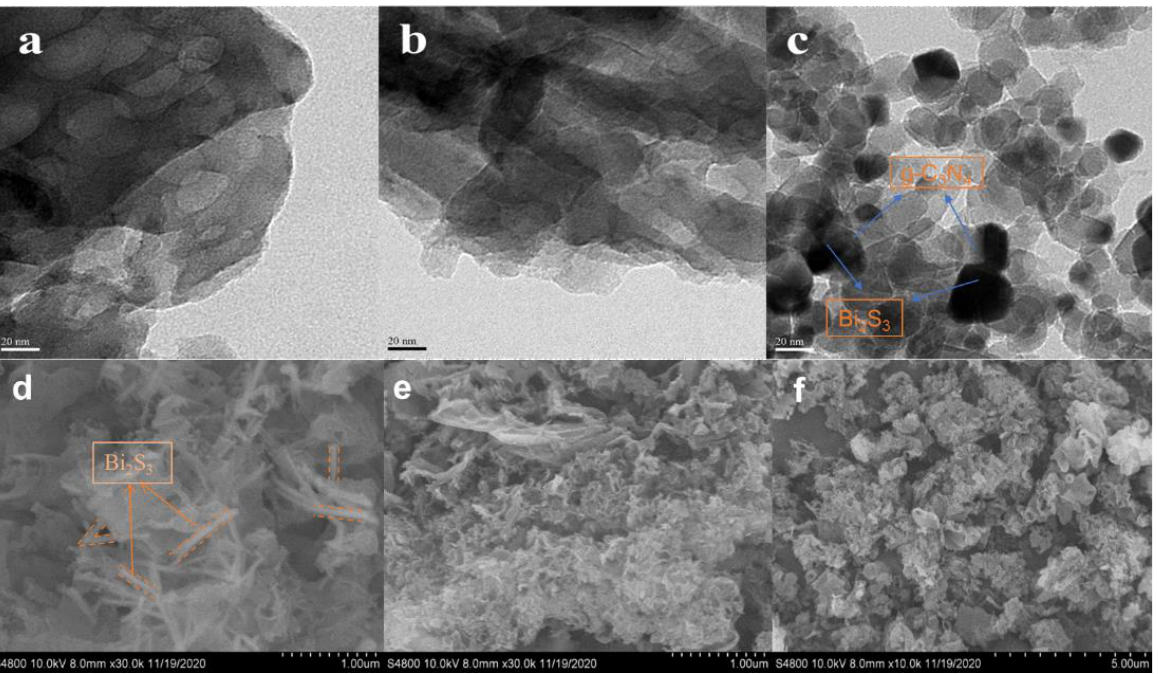
Figure 2. The TEM images of the synthesized ( a ) Bi 2 S 3 , ( b ) g-C 3 N 4 , and ( c ) Bi 2 S 3 @g-C 3 N 4 . The SEM images of the synthesized ( d ) Bi 2 S 3 , ( e ) g-C 3 N 4 , and ( f ) Bi 2 S 3 @g-C 3 N 4 .